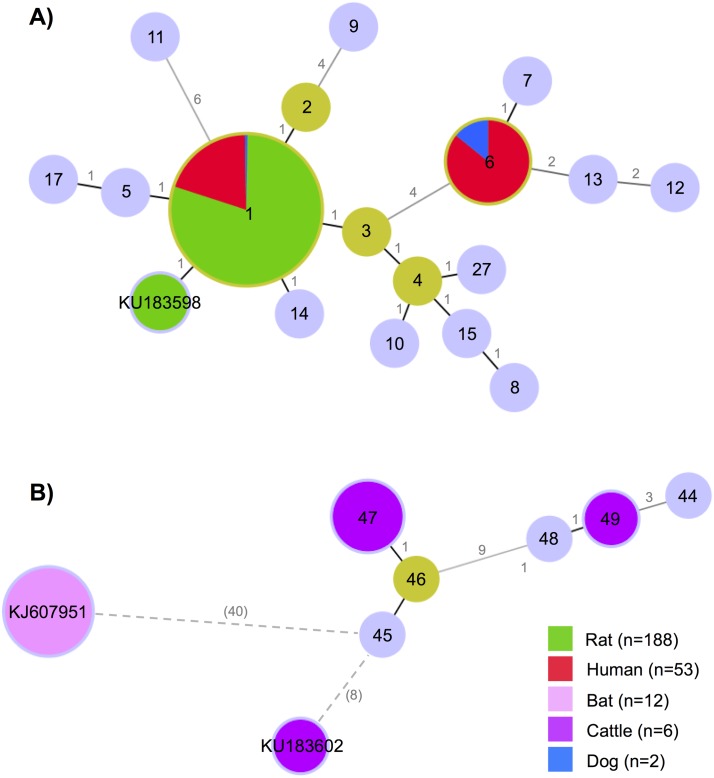
Minimum spanning trees of Leptospira based on secY gene (501 bp sequence), including our sequences from Reunion Island and twelve bat sequences previously published [46].A) Minimum spanning tree of Leptospira interrogans (n = 257) and B) Leptospira borgpetersenii (n = 22). We used the goeBURST Full MST algorithm. The alleles are identified by a number (secY-1 to secY-54, see http://www.pubmlst.org/leptospira/) or an identifier; the circle size reflects their abundance in the data set. Group founders are in light green and common nodes are in light blue, except when overlapping with alleles from our sample, with specific colours referring to hosts (see legend). Links between the elements uses a grayscale, with lighter gray links showing more differences; the number of differences is indicated on the links. For two incomplete secY sequences (< 501 bp), the numbers of differences, shown in parentheses, were calculated on the overlapping nucleotides only, i.e. 443 for KU183602, and 491 for KJ607951.